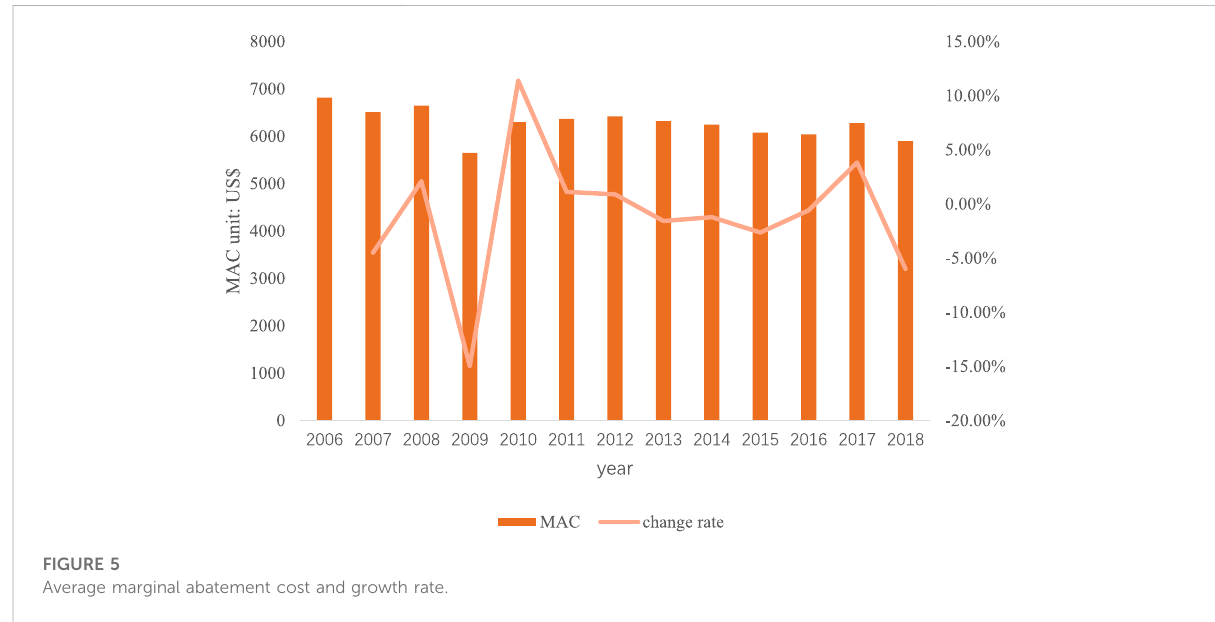
FIGURE 5 Average marginal abatement cost and growth